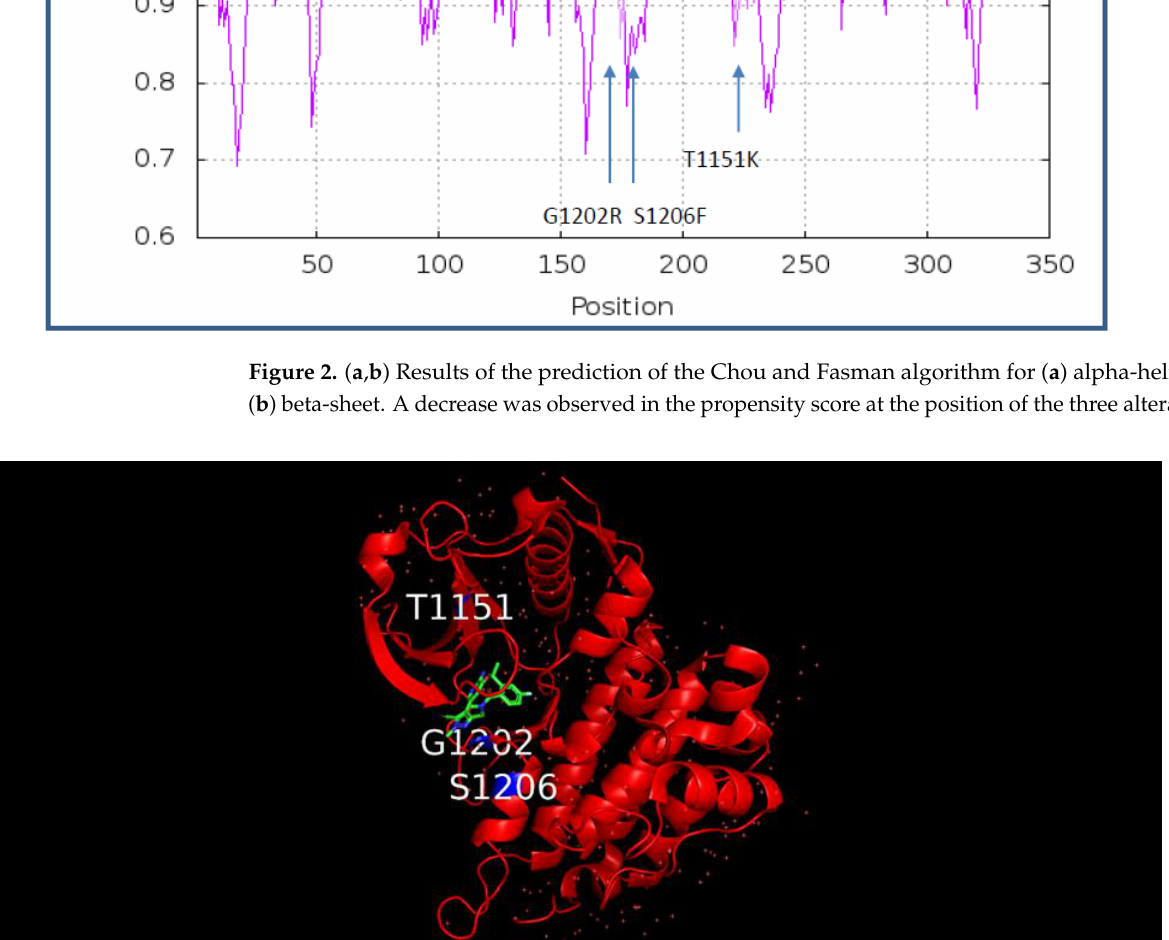
Figure 3. Crystallographic structure of ALK protein (red) in complex with PF-06463922 (lorlatinib), the structure of which is in green. The position of the three mutated residues is highlighted in blue (PDB accession number: